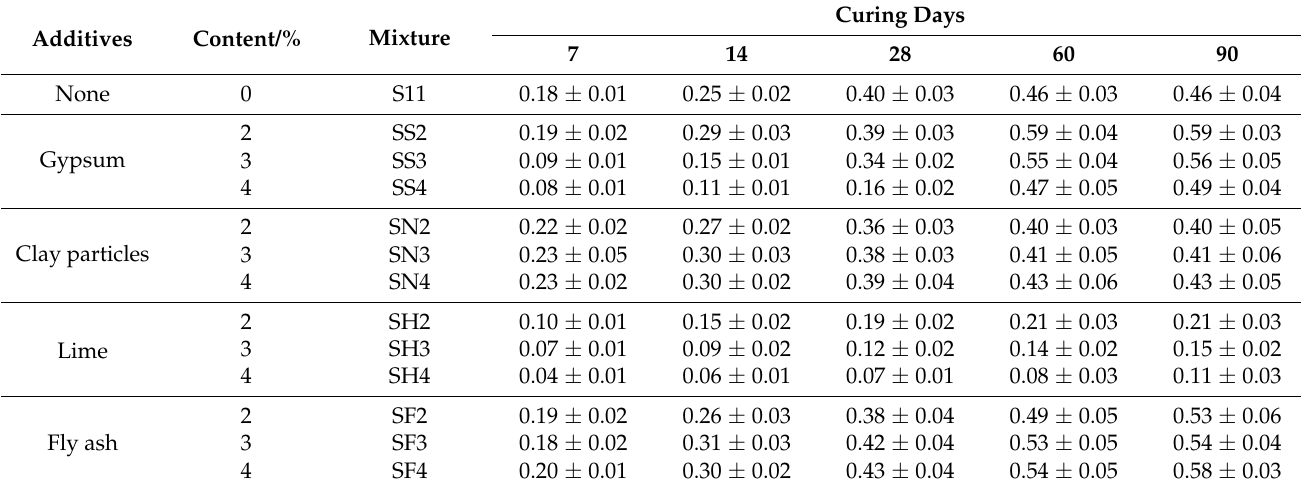
Figure 7. Curve of indirect tensile strength with optimal content of the additives.